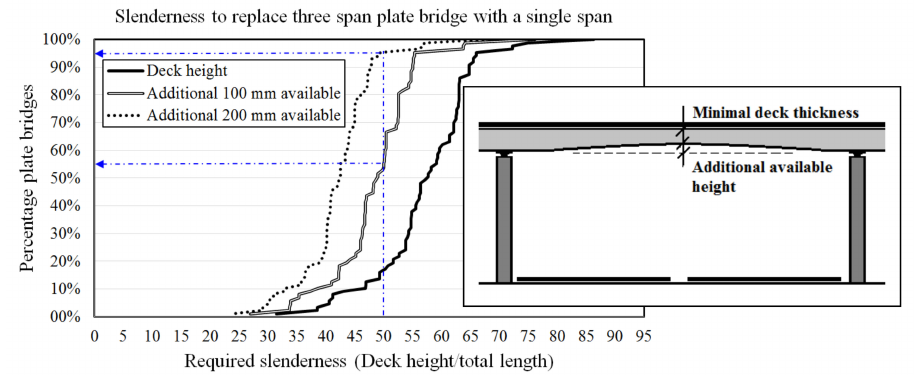
Figure 5. Required deck slenderness to realize a significant replacement task: processed data from Reference